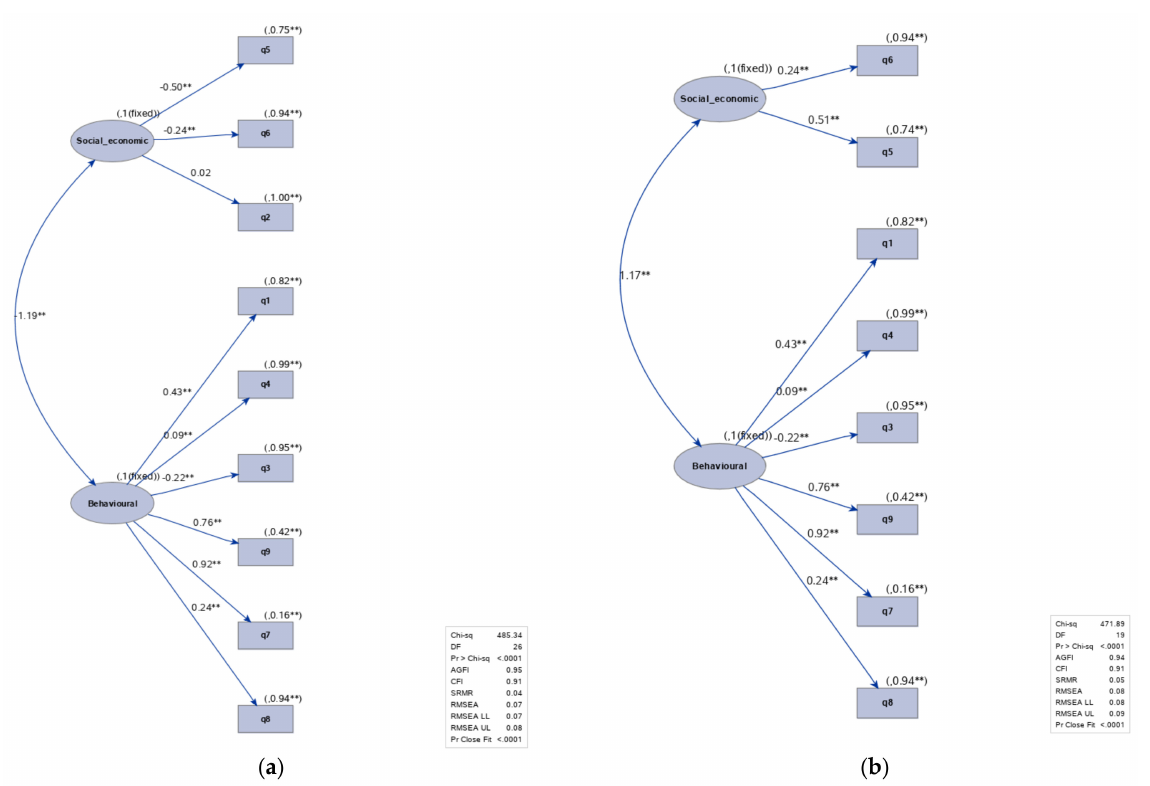
Figure 9. Path diagrams for the post-trial questionnaire data set ( a ) initial ( b ) after